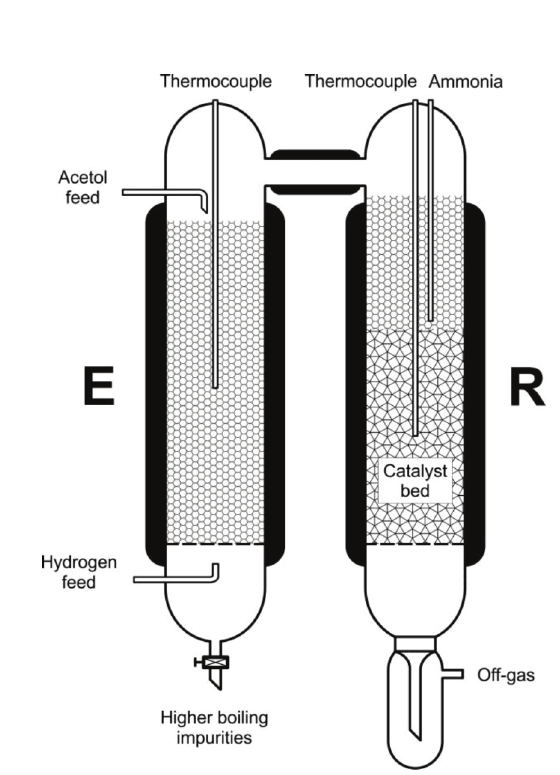
Fig. 1 – Reaction apparatus of the one-step reductive amina- tion of acetol with ammonia in the gas phase. E: acetol evapo- rator; R: fixed-bed